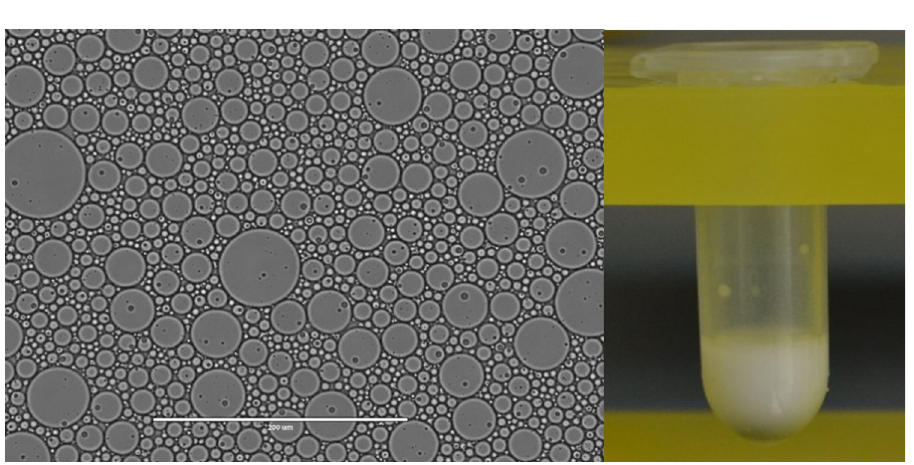
Fig 10. Emulsion made with fluid C (protocol 2). Left: transmission microscope image of droplets. Scale bar is 200 μ m. Right: picture of the emulsion formed by shaking 100 μ L of buffer and 300 μ L of fluid C with 2% of the surfactant a-R 2 containing the Hx hydrophobe. The emulsion is formed by shaking the contents in a Snap-Cap f Microcentrifuge Biopur ™ Safe-Lock ™ Tube containing a 6 mm stainless steel bead. The tube was fitted in a TissueLyser II and shaken for 10 seconds at 15 Hz followed by 7 seconds at 17 Hz. Scale bar is 400 μ m. Pictures are representative of several trials.